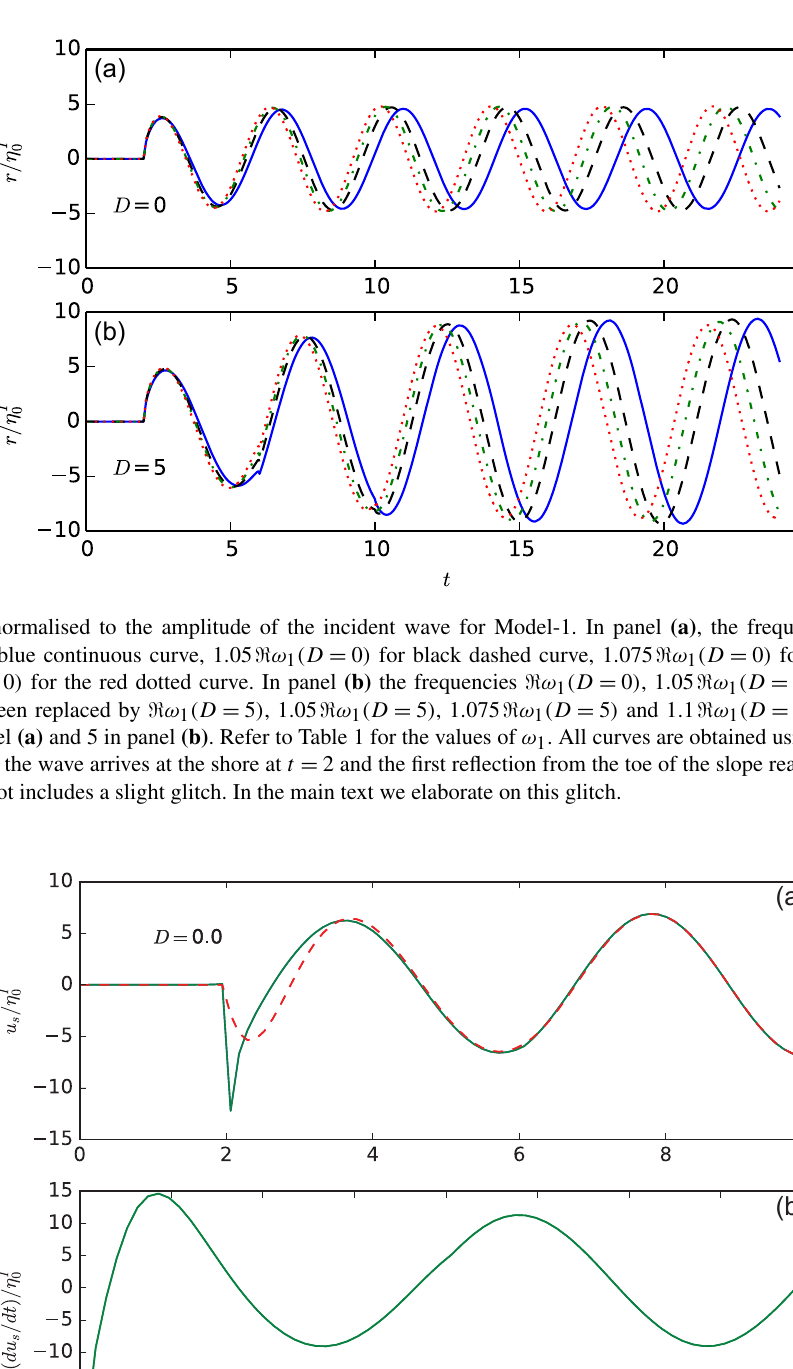
sin ( (cid:60) ω 1 (t + (x − 0